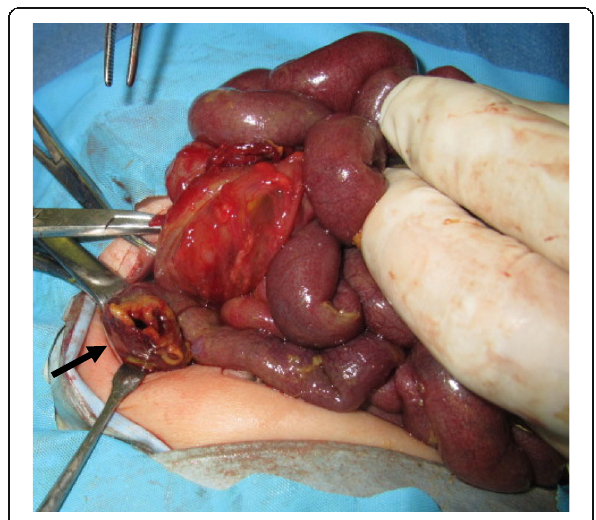
Fig. 2 Laparotomy for cecal perforation (arrow) on the 3rd day of life